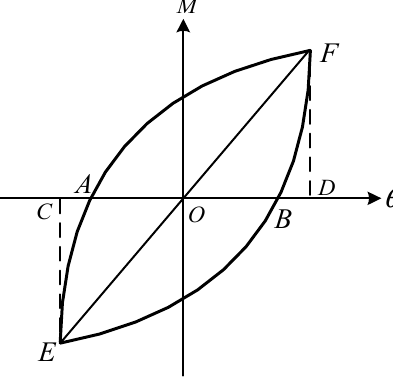
Figure 24. Energy dissipation loop.